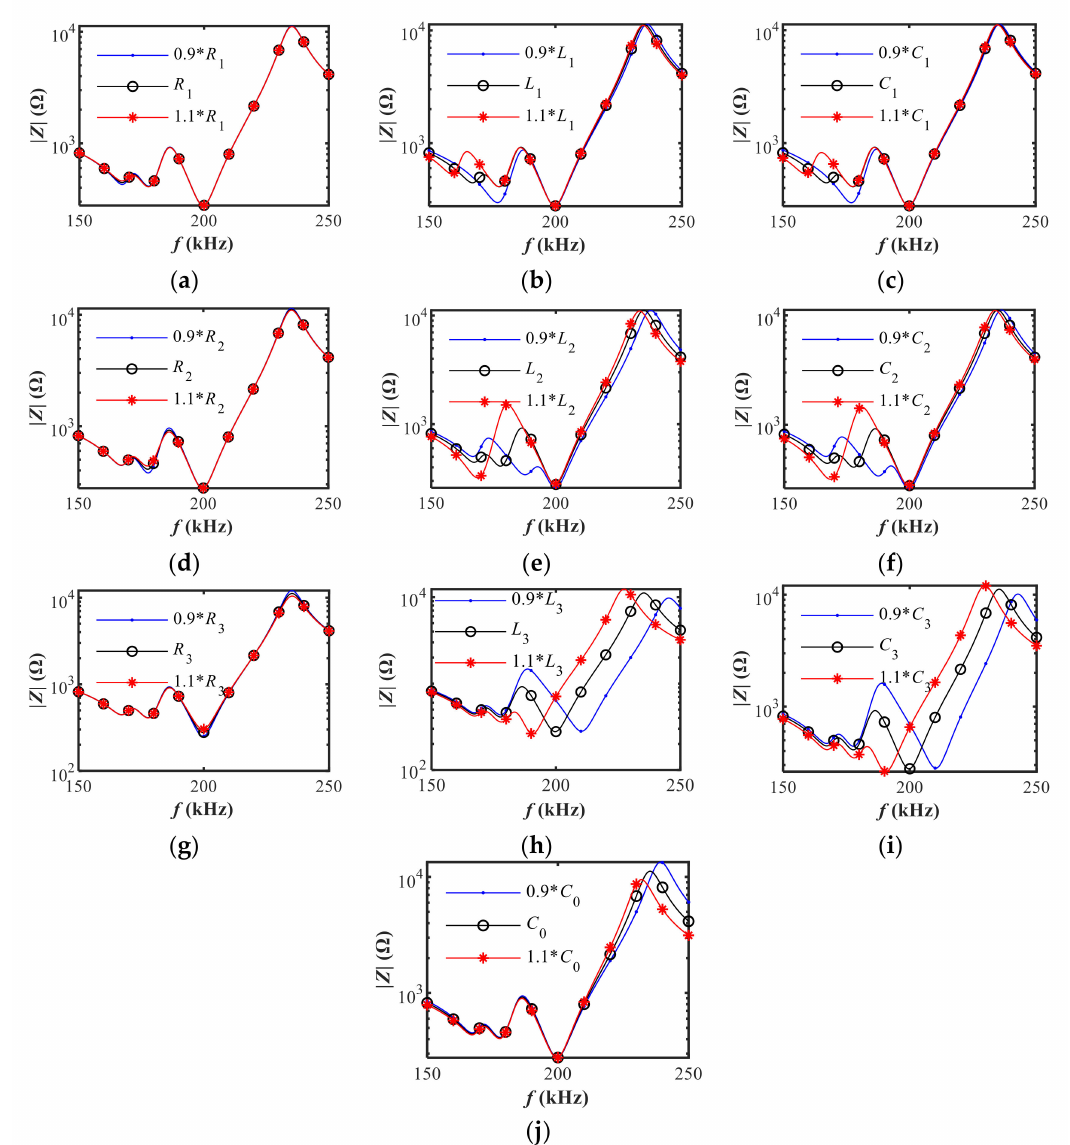
Figure 8. The e ff ect of equivalent parameter variations on the electrical impedance magnitude: ( a ) R 1 ; ( b ) L 1 ; ( c ) C 1 ; ( d ) R 2 ; ( e ) L 2 ; ( f ) C 2 ; ( g ) R 3 ; ( h ) L 3 ; ( i ) C 3 ; ( j ) C 0